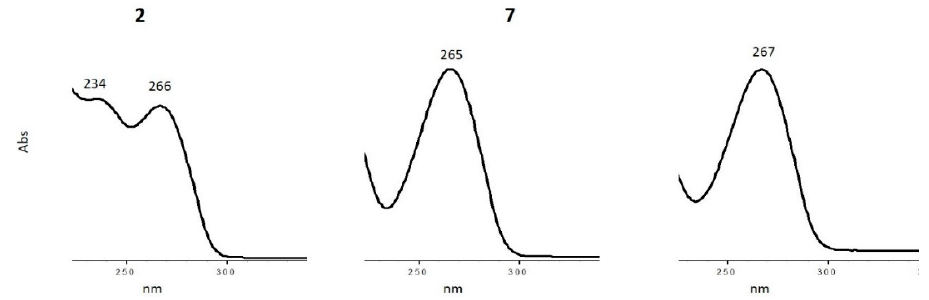
Figure 12. In-line UV-visible spectra (220–350 nm) of chromatogram of Figure 11. From left to right: 2 (Rt = 21 min), degradation product 7 at Rt = 22 min and a minor product at Rt = 22.5 min. LC-ESI/MS analysis (high resolution) allowed for us to identify product 2 as an isomer of